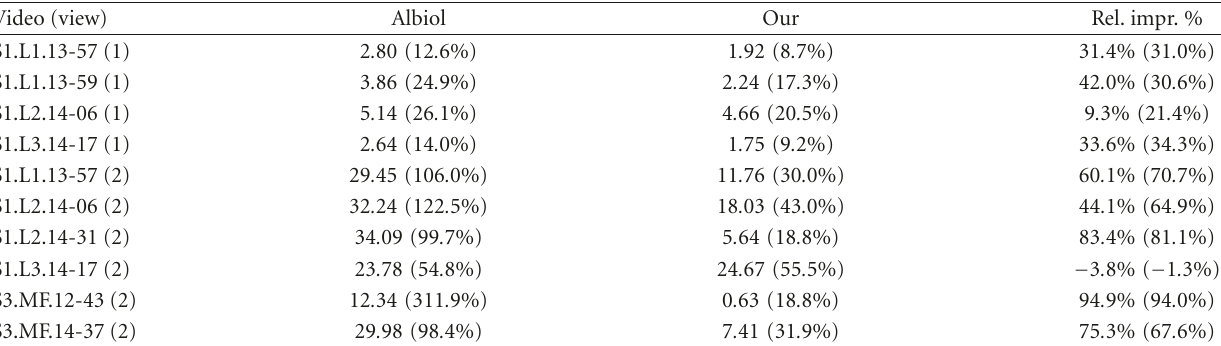
Table 2: Performance of Albiol’s algorithm and of the proposed one. In each cell there are reported the values of the MAE and of the MRE (in parenthesis) performance indices for both Albiol’s and our people counting method, while in the last column there are reported the relative improvements.